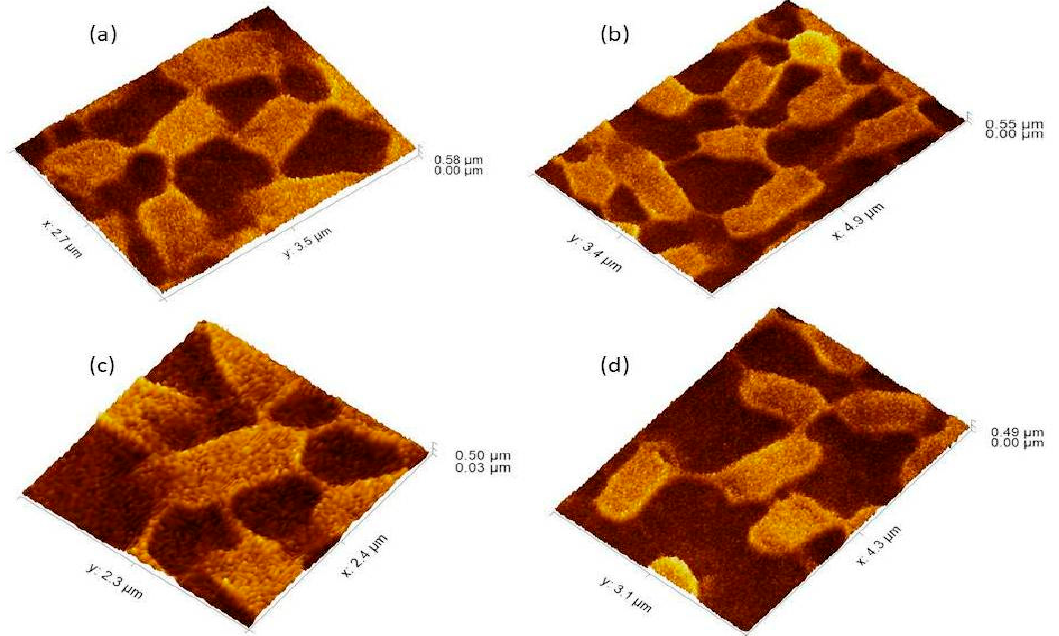
Figure 4. The 3Drepresentation highlighted the cells that occupied the lower base of biofilm consortia and adhered to the glass surface. This population was grown between two slides under a weight of (15.45 g). Due to the weight pressure, cells were unable to maintain the typical P. aeruginosa cylindrical rod shape. ( a ): Cells with a compressed shape (Brick-like appearance) due to weight pressure. ( b ): Heterogeneous (large and small rod) cells attached to the glass surface and connected through a nanotube. ( c ): A single cell connected to multiple (6) neighbours through a nanotube. ( d ): Cells connected to one or two neighbours through a nanotube.